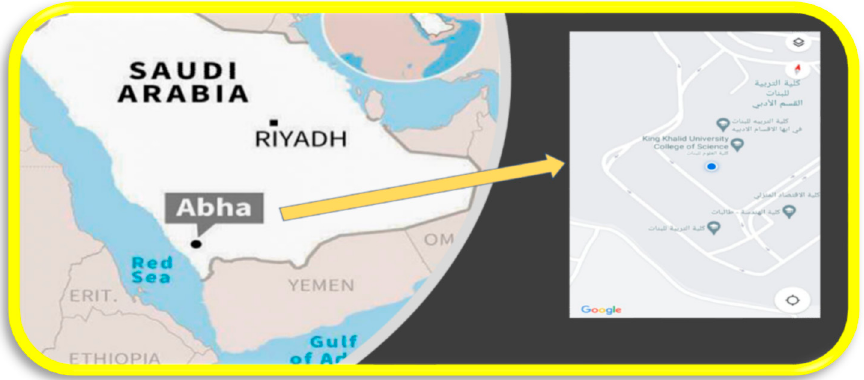
Figure 1. Location of College of Science, King Khalid University, Abha, K.S.A.